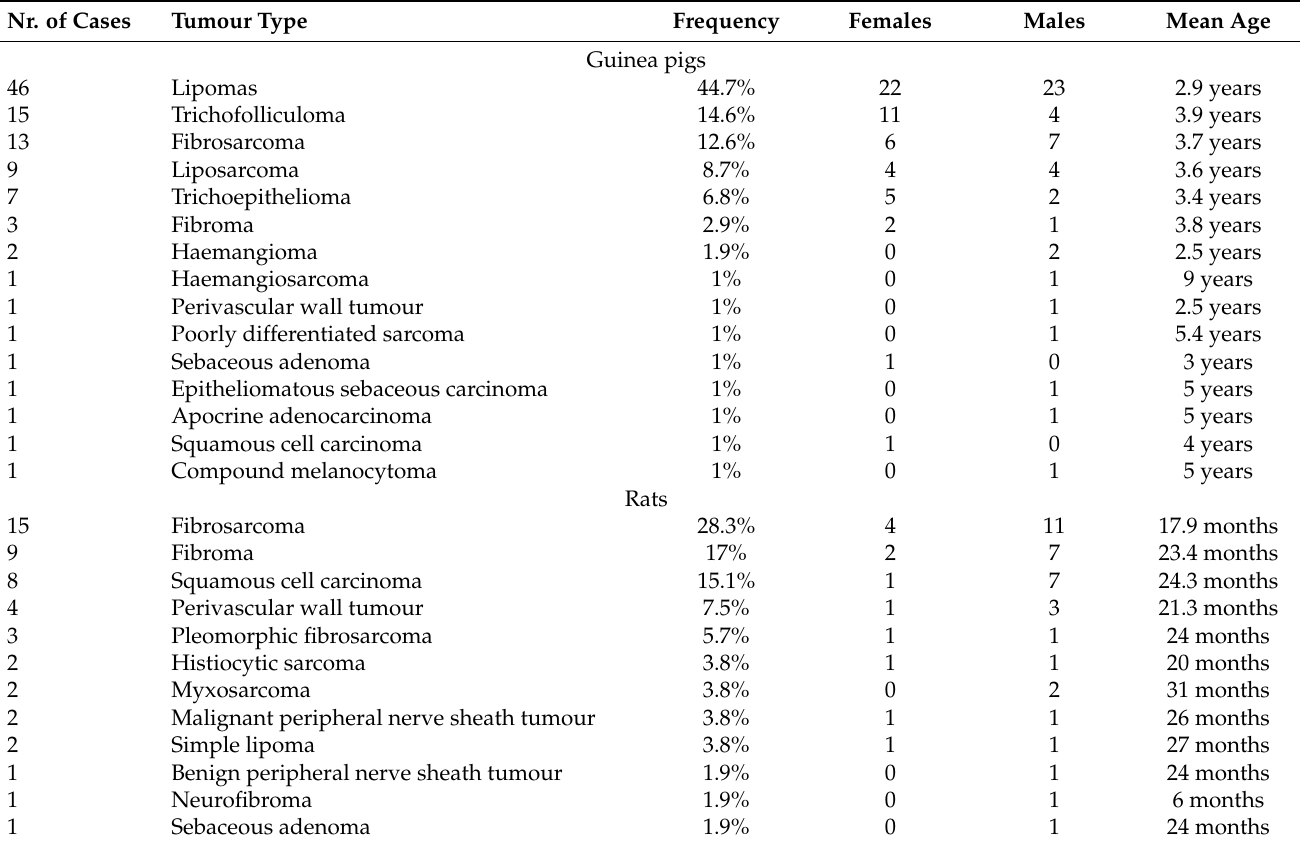
Figure 8. Epithelioid haemangioma, facial (nasal) area, chinchilla. Large and plump tumour cells form small blood vessels and solid aggregates. HE. Table 3. Incidence of particular tumour types in small mammal pets, depending on the sex and